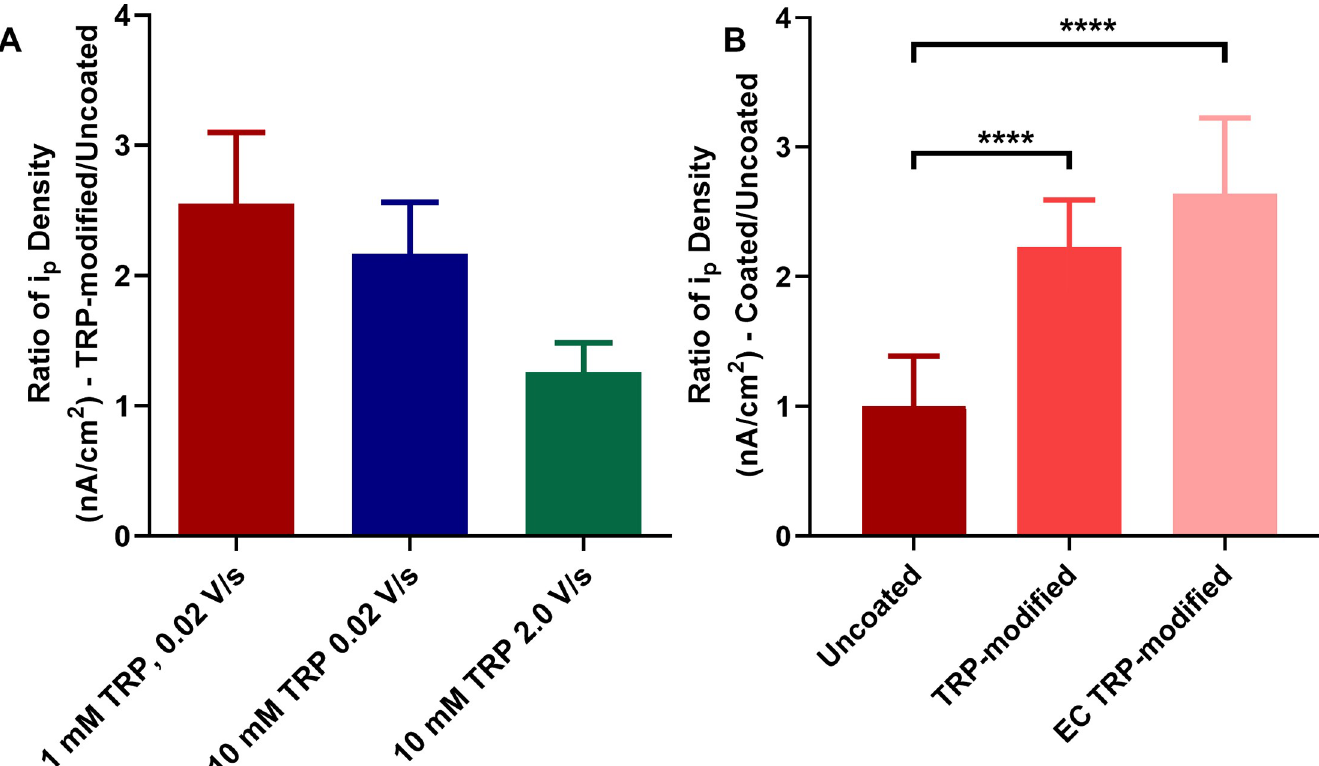
Fig 2. A. Ratio of i p density for DA (TRP-modified/uncoated) using electrodes treated with either 1 mM TRP at 0.02V/s, 10 mM TRP at 0.02 V/s, or 10 mM TRP at 2.0 V/s is shown. Collections were performed for 1 μ M DA for 30 seconds. One-way ANOVA analysis indicated no significant difference between means (p = 0.1279), n = 4 per group. B. Collections of 1 μ M DA were performed using the uncoated electrode, TRP-modified electrode, and EC TRP-modified electrode. One-way ANOVA analysis indicated a significant difference between means (p < 0.001), n = 4 per group. Post hoc analysis (multiple comparisons, Tukey’s test); Uncoated vs. TRP- modified (p < 0.0001), Uncoated vs. EC TRP-modified (p < 0.001), TRP-modified vs. EC TRP-modified (p =